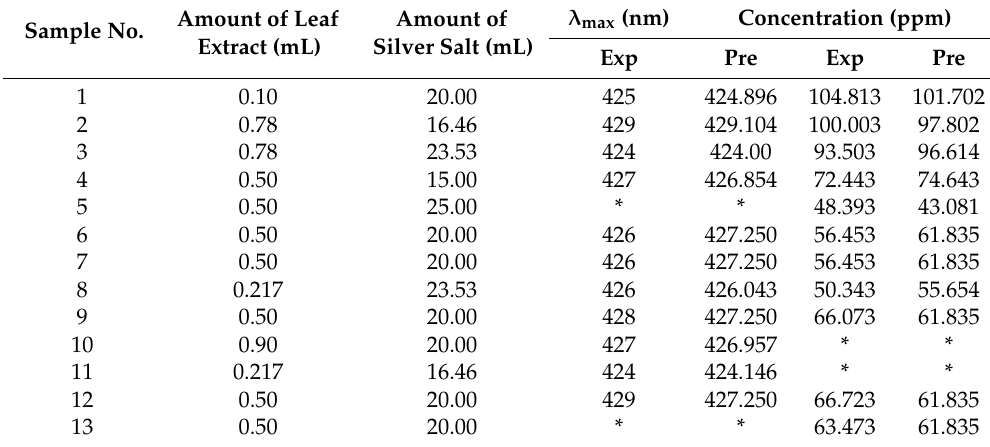
Table 1. Experimental runs according to the central composite design (CCD) and response variables for synthesis of Ag NPs.